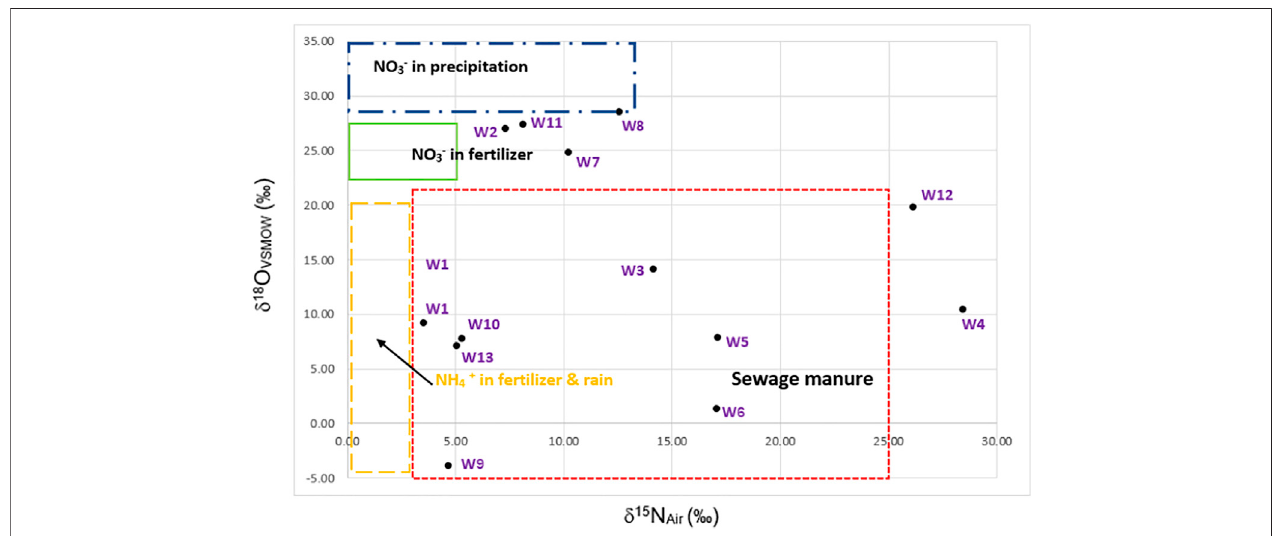
TABLE 2 | Physico-chemical properties of eight soil samples collected from the sugarcane fi eld. Sample